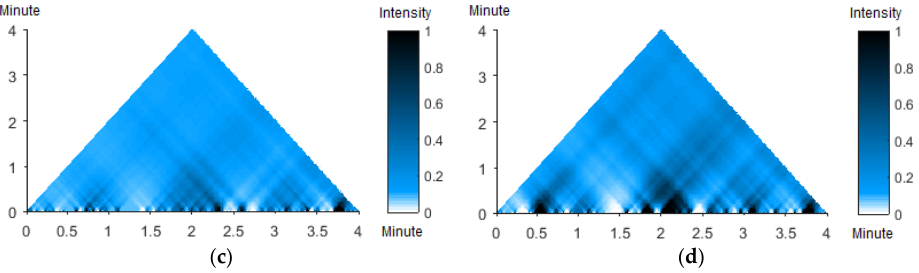
Figure 7. The local interaction intensities of each of the four players for the attraction pattern: ( a )